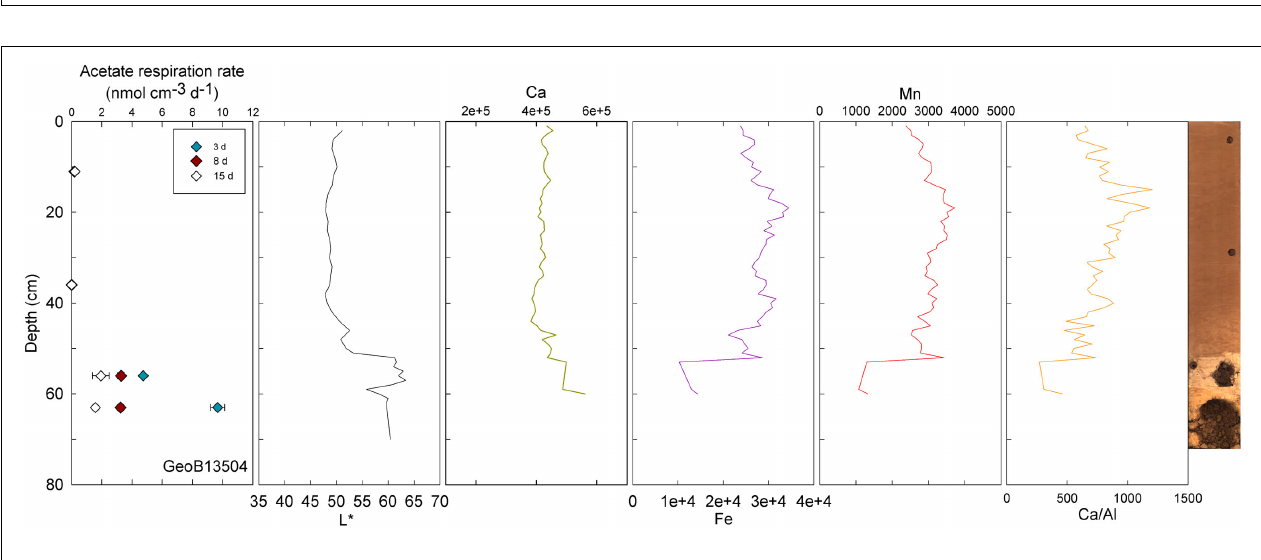
FIGURE 3 | GeoB 13504 activity rates (at 11, 36, 56, and 63cm) and detailed lithological features (L*, Ca, Fe, Mn, and Ca/Al). GeoB 13504 is